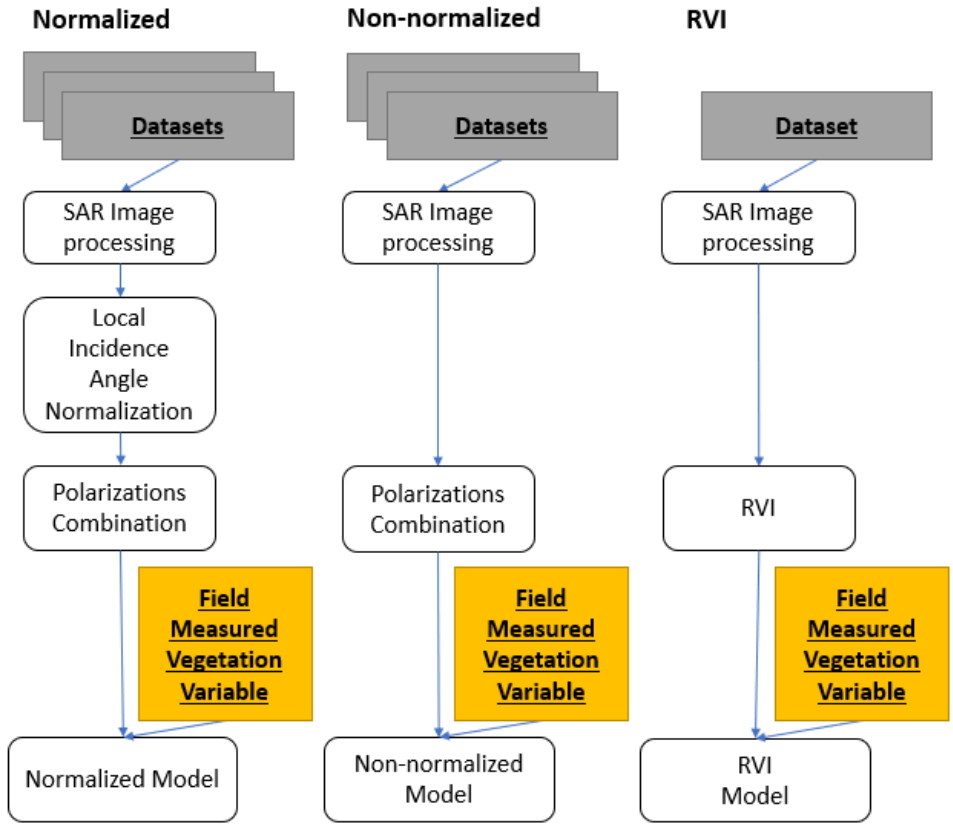
Figure 5. Derivation of the dual-polarized normalized (with σ 0 or β 0 normalization), non-normalized, and RVI models.